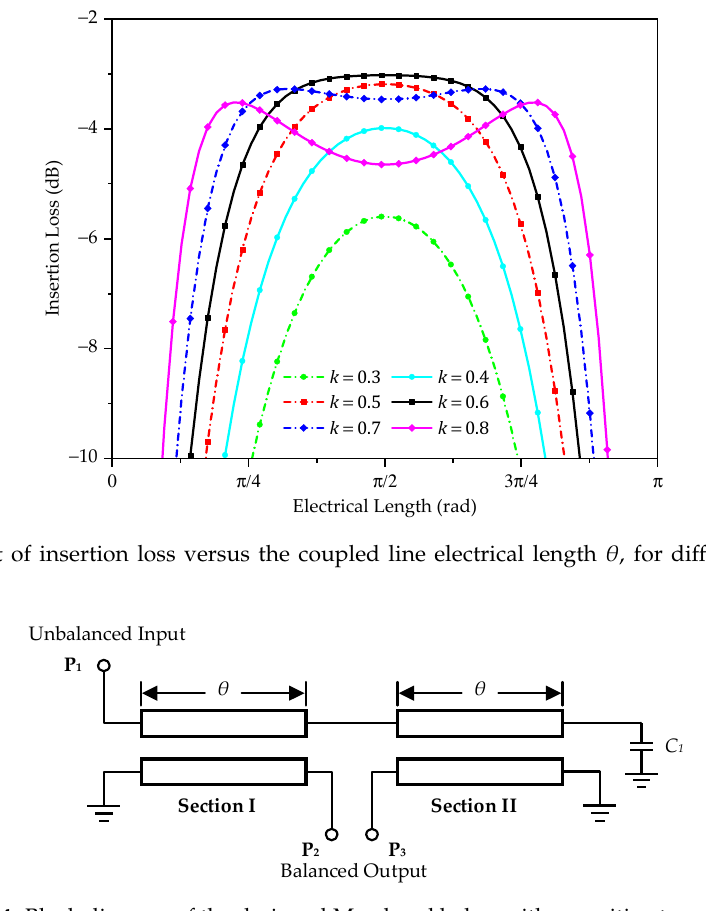
( d ) Figure 6. ( a ) Cross-section of the proposed balun; ( b ) simplified model of the proposed balun; ( c ) even mode analysis; ( d ) odd mode analysis. Then from [13], the coupling coefficient 𝑘𝑘 can be expressed as 𝑘𝑘 = 𝐶𝐶 𝑚𝑚 �𝐶𝐶 𝑎𝑎 + 𝐶𝐶 𝑚𝑚 �𝐶𝐶 𝑏𝑏 + 𝐶𝐶 𝑚𝑚 (3) where 𝐶𝐶 𝑚𝑚 = 2( 𝐶𝐶 𝑚𝑚1 + 𝐶𝐶 𝑚𝑚2 + 2 𝐶𝐶 𝑚𝑚12 ) , and 𝐶𝐶 𝑎𝑎 = 𝐶𝐶 𝑏𝑏 = 𝐶𝐶 𝑠𝑠1 + 𝐶𝐶 𝑠𝑠2 . Therefore, 𝑘𝑘 increases as 𝐶𝐶 𝑚𝑚 increases. Compared with the edge-coupled structure, where either 𝐶𝐶 𝑚𝑚1 or 𝐶𝐶 𝑚𝑚2 exists, or the broadside-coupled structure with only mutual capacitance 𝐶𝐶 𝑚𝑚12 , using the proposed edge- and broadside-coupled hybrid configuration, a higher 𝐶𝐶 𝑚𝑚 can be obtained, hence maximizing coupling 𝑘𝑘 . Using 6 μm metal width for both primary and secondary coupled lines, for the edge-coupled structure, the coupling 𝑘𝑘 is limited by the minimum metal spacing rule defined by the foundry process, with a highest simulated 𝑘𝑘 of 0.57; for the broadside-coupled structure, it is limited by the